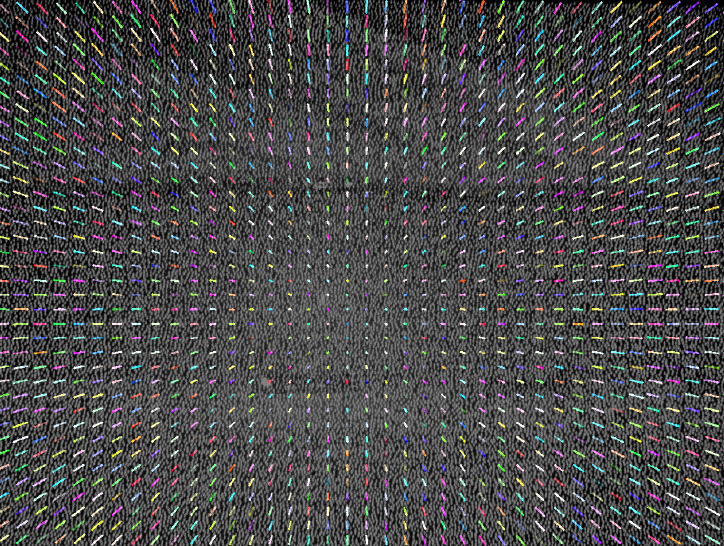
Figure 4. Expansion of the captured IR pattern with the temperature using the optical flow